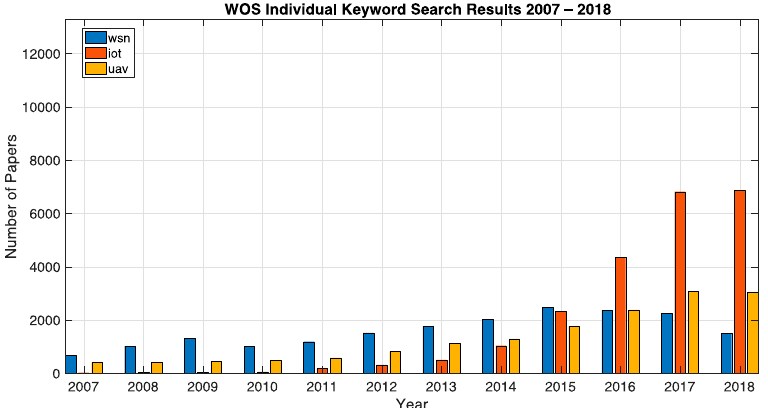
Figure 3. Web of Science (WOS) search results on keywords between 2007 and 2018: UAV, WSN and IoT, separately.